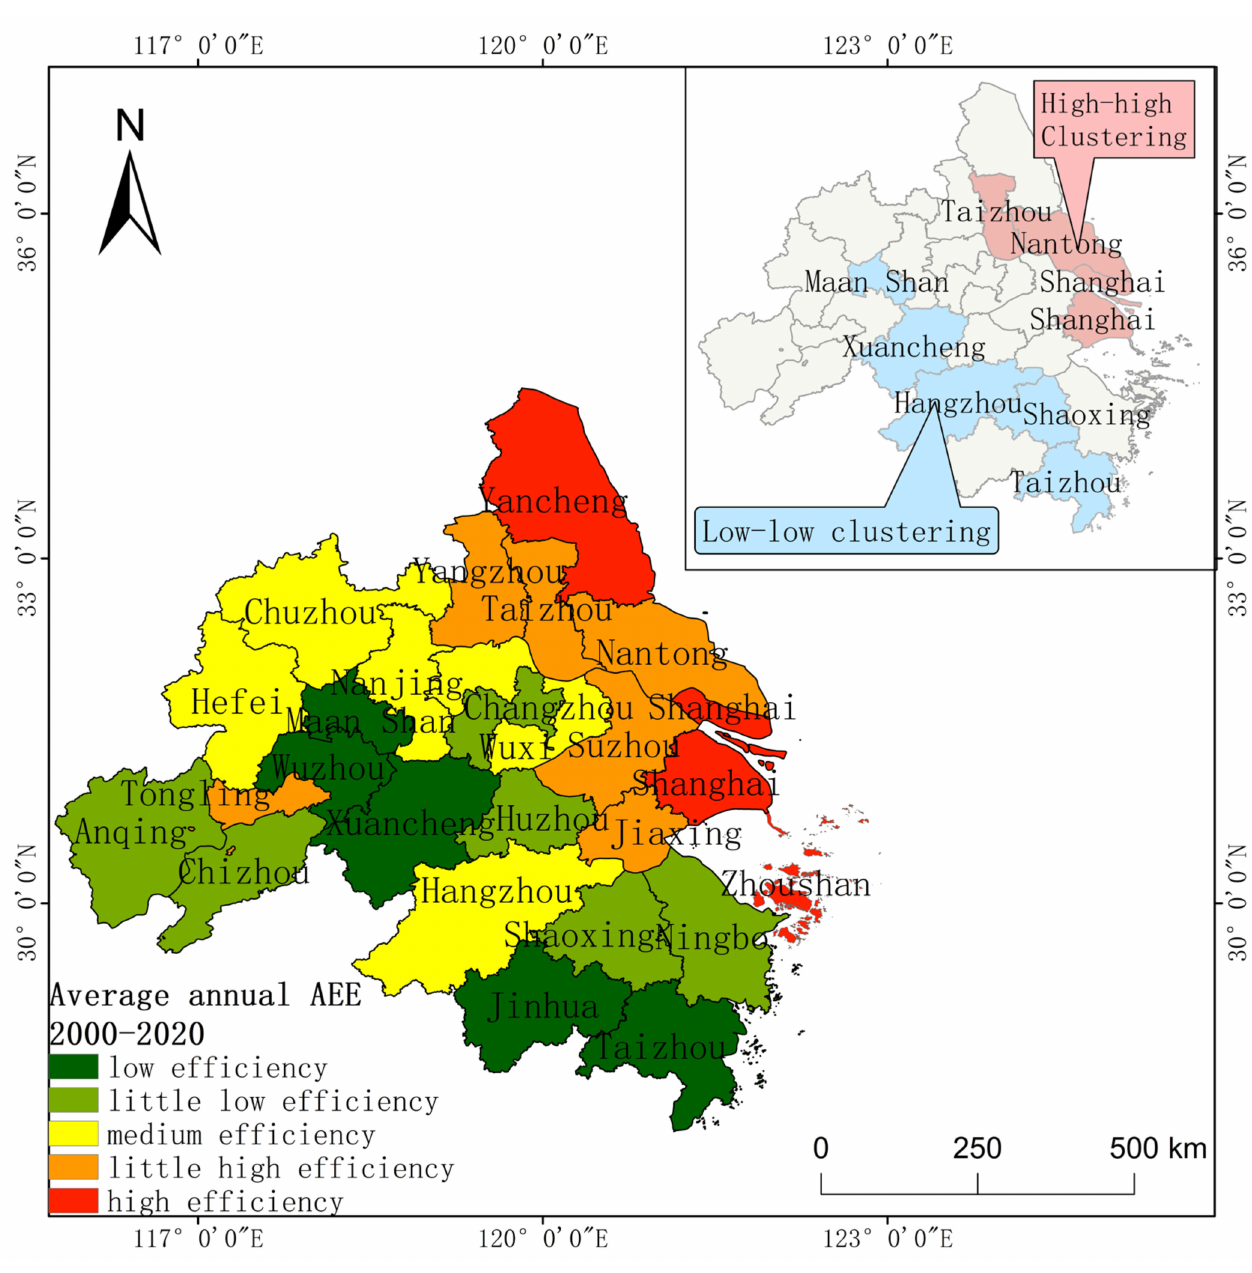
Figure 6. Annual average AEE and spatial distribution of clustered areas from 2000 to